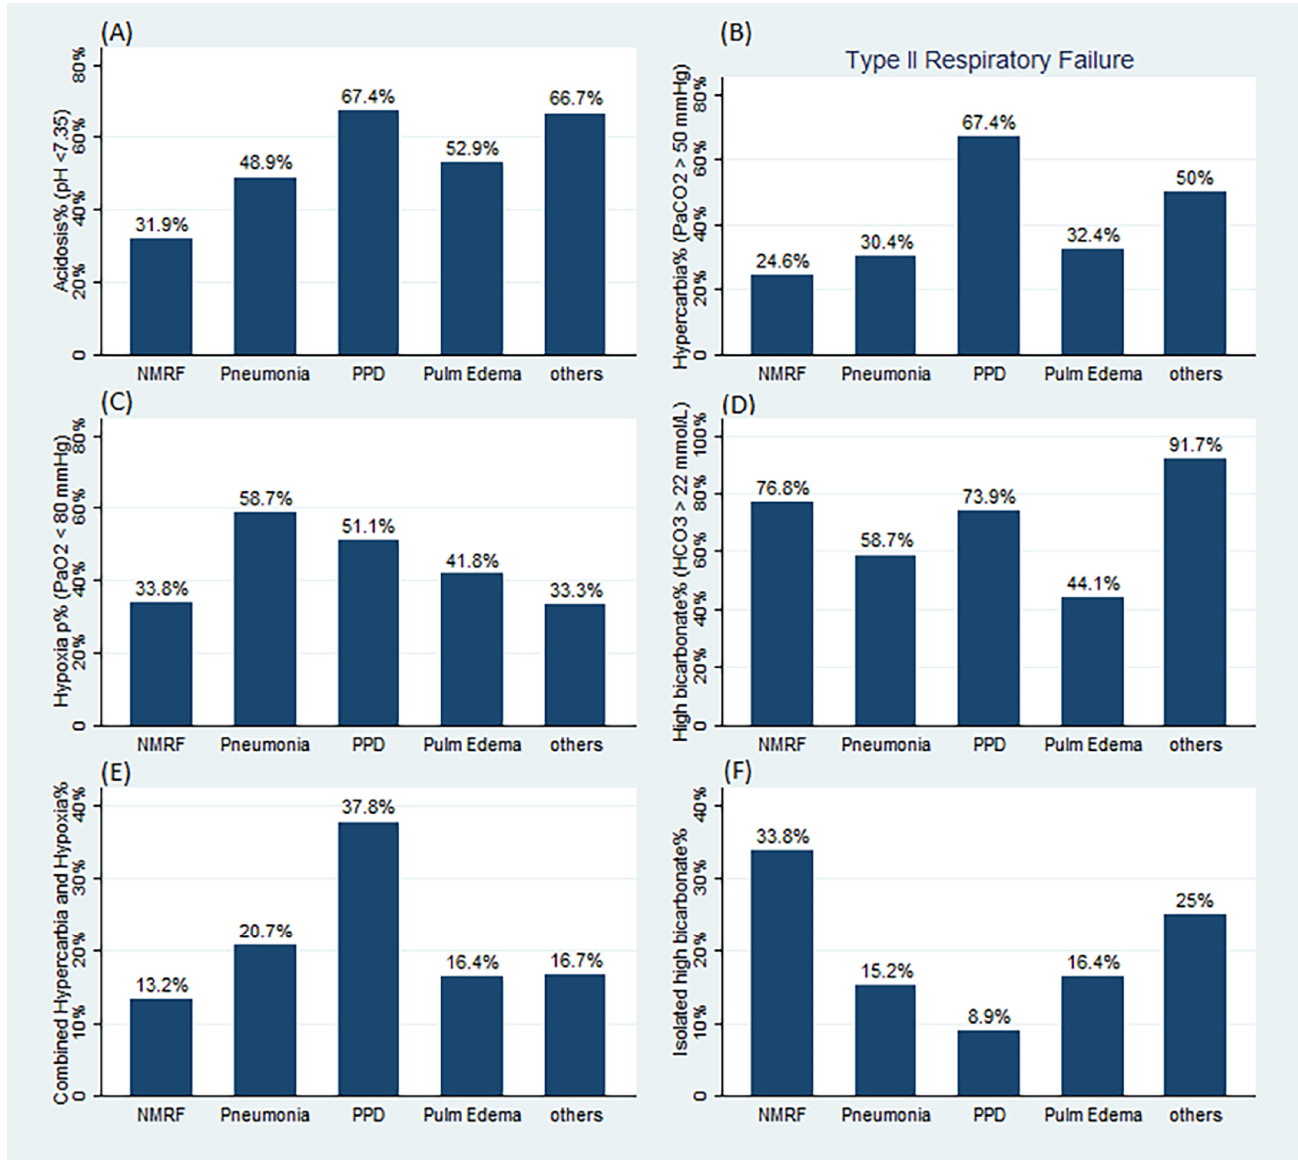
Figure 2. Prevalence of ABG abnormalities per category of respiratory failure. ( A ) Prevalence of acidosis (pH < 7.35). ( B ) Prevalence of hypercarbia and type II respiratory failure (PaCO 2 > 50 mmHg). ( C ) Prevalence of hypoxia (PaO 2 < 80 mmHg). ( D ) Prevalence of high bicarbonate level (HCO 3 > 22 mmol/L). ( E ) Prevalence of combined hypercarbia and hypoxia. ( F ) Prevalence of isolated high bicarbonate level. NMRF: neuromuscular respiratory failure, PPD: primary pulmonary diseases, Pulm Edem: pulmonary edema. For a comparison p values, refer to Table S1 in the Supplementary Materials.